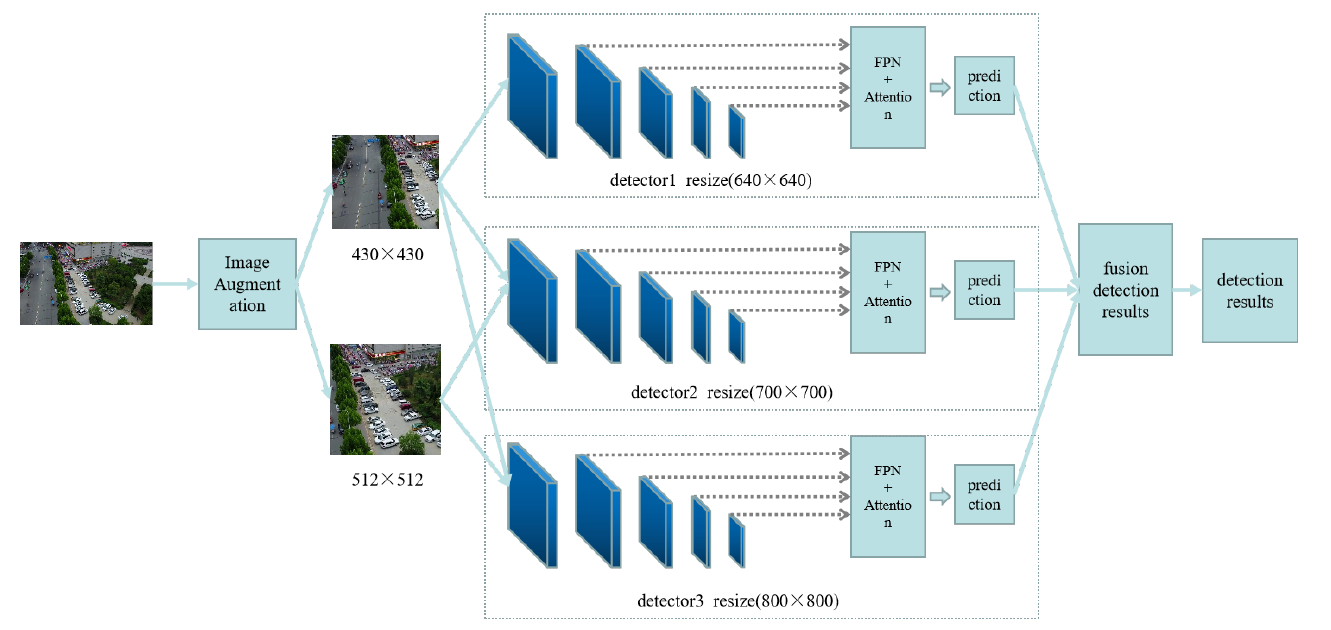
Figure 2. An illustration of our framework. Our network consists of two parts. One part is the data augmentation, which use the center of the ground truth object as the image division center to divide image. Moreover, it can increase the number of objects, making it easier for detectors to detect. The second part is the Multi-Head-Attention-Yolo. We add a detection header on the feature map and use the attention mechanism on each detection